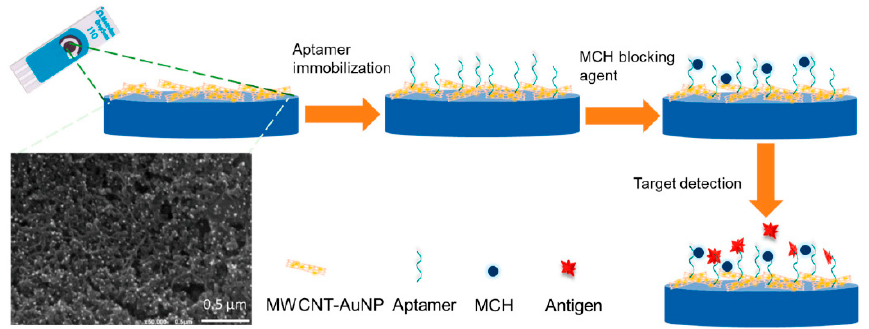
Figure 1. Schematic diagram of the development process of PSA biosensor.